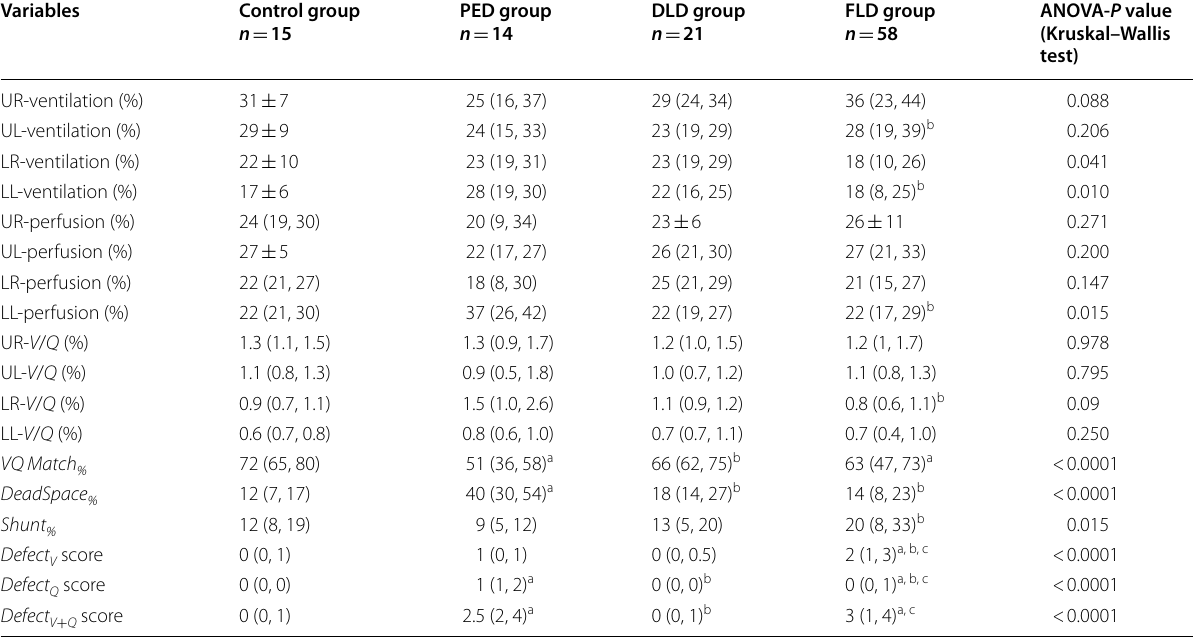
Table 2 Comparisons of EIT-related parameters in four groups